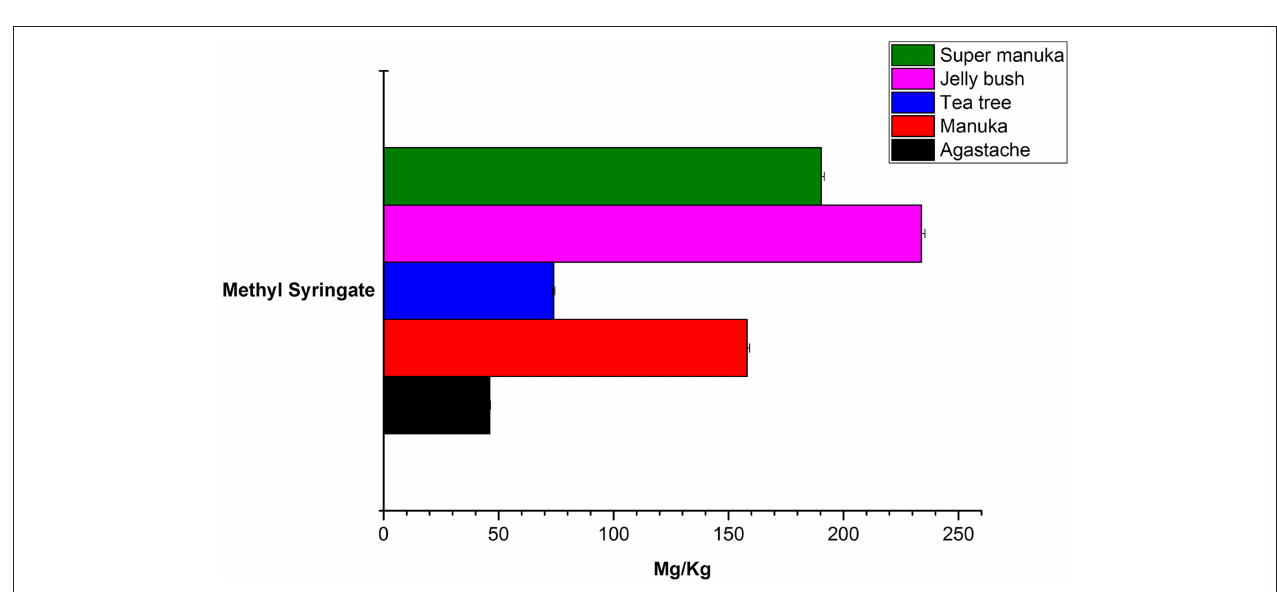
FIGURE 7 | Comparative analysis of methyl syringate in